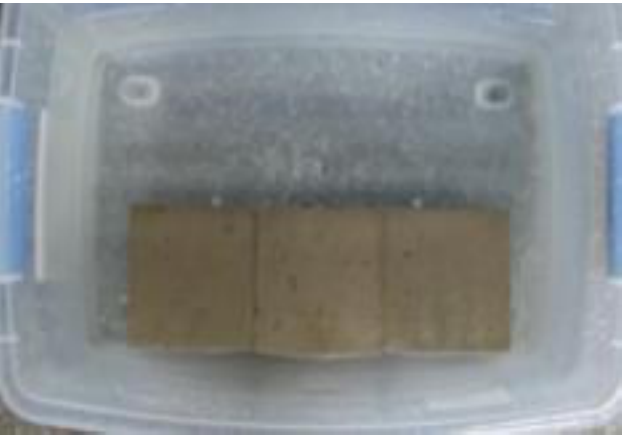
Figure 2. GPC specimens kept in sulfuric acid.